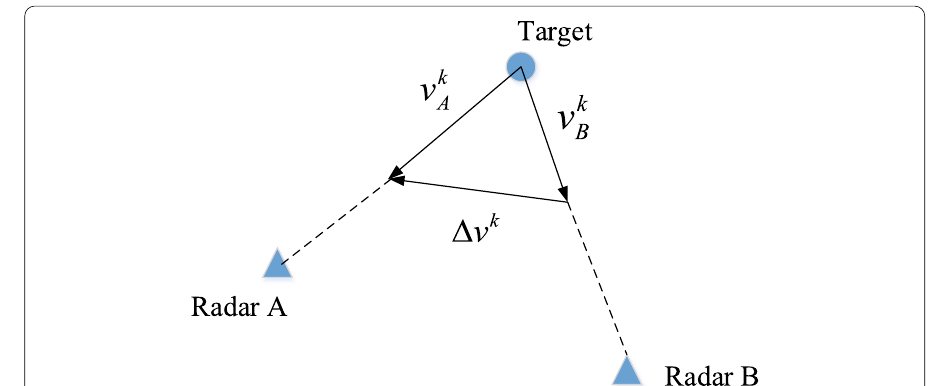
Fig. 4 The target Doppler from radars A and